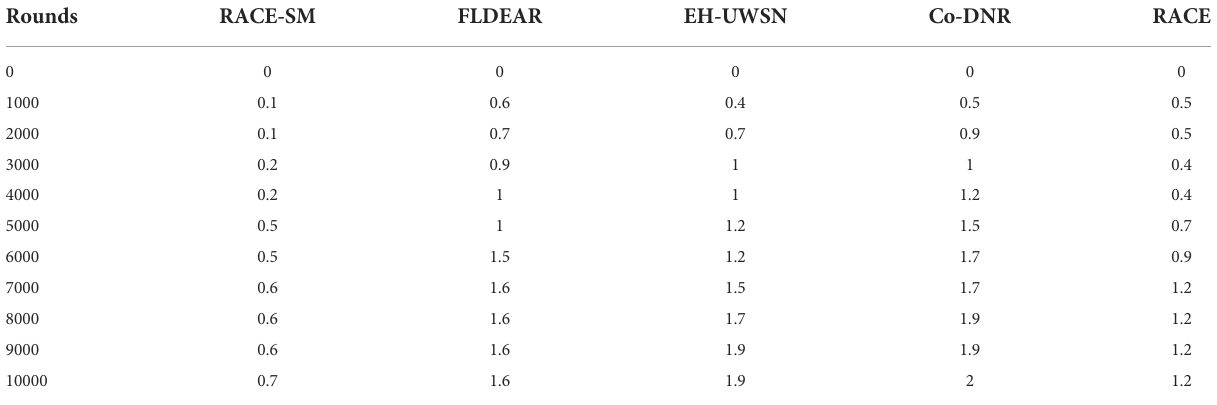
TABLE 5 Protocols addressing End-to-End Delay.